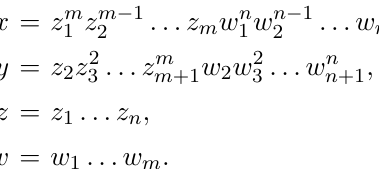
Figure 2. Toric diagram of the